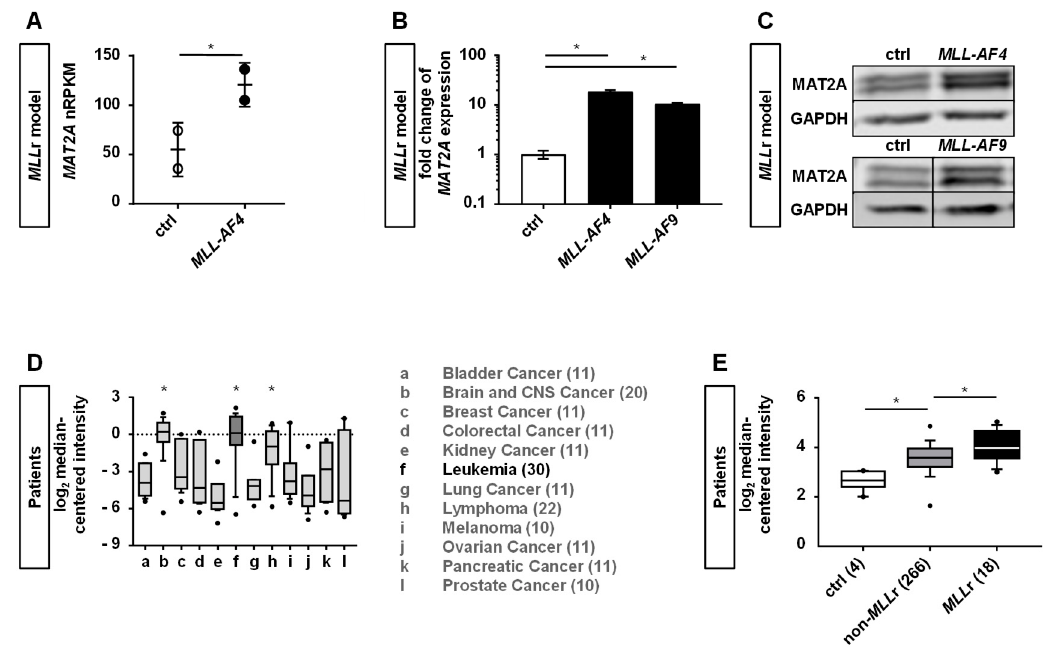
Figure 1. Human CRISPR/Cas9- MLL r model reveals MAT2A as a possible target in MLL r leukemia. ( A ) RNA sequencing of human CRISPR/Cas9- MLL-AF4 (two different donors, n = 2) compared to the respective controls (ctrl, n = 2, CD34 + huCB cells nucleofected with Cas9 alone and cultured for the same time) revealed upregulated expression of MAT2A . Values in normalized reads per kilobase million (nRPKM), each dot represents a sample. ( B ) Validation of MAT2A expression was performed by RT-qPCR. MLL-AF4 and MLL-AF9 cells were normalized to culture-expanded CD34 + huCB control cells (ctrl). Experiment was performed in biological duplicates ( n = 2) with horizontal bars representing the mean. Error bars indicate standard deviation (SD). One-way ANOVA was used with Dunnett correction: * p < 0.05. ( C ) Representative Western blot analysis shows increased MAT2A expression in MLL r cells compared to culture expanded CD34 + huCB control cells (factor 1.8 for MLL-AF4 and factor 1.7 for MLL-AF9 ). Glyceraldehyde-3-phosphate dehydrogenase (GAPDH) was used as the loading control. Blots are cropped and full images are displayed in Figure S1. ( D ) Upregulated MAT2A expression in leukemic patient samples compared to other cancer types (data from oncomine.org) [19]. Boxes indicate the range from the 25th through 75th percentiles; the horizontal lines represent the median; error bars indicate the range from 10th through 90th percentiles; the dots show the maximum and minimum values. Student’s t test was used: * p < 0.05. ( E ) MAT2A expression in MLL r leukemia compared to non- MLL r leukemia and healthy controls, respectively (GSE28497, data from oncomine.org) [20]. Boxes indicate the range from 25th through 75th percentiles; the horizontal lines represent the median; error bars indicate the range from 10th through 90th percentiles; the dots show the maximum and minimum values. Mann–Whitney U test was used: * p < 0.05.